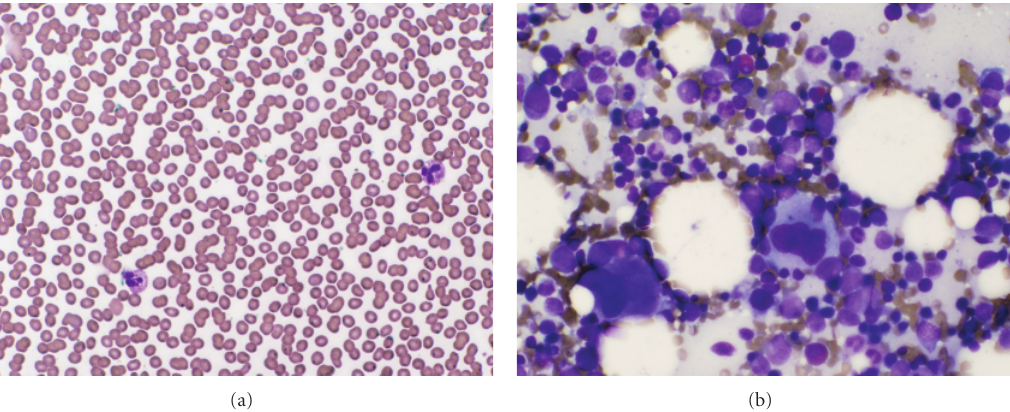
Figure 2: Peripheral blood film (a) and bone marrow aspirate (b) at ITP diagnosis, both 40x